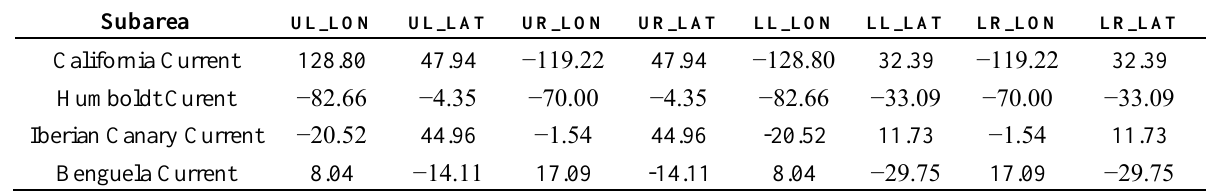
Table 2. Latitude and longitude location of corners of color code areas for Figure